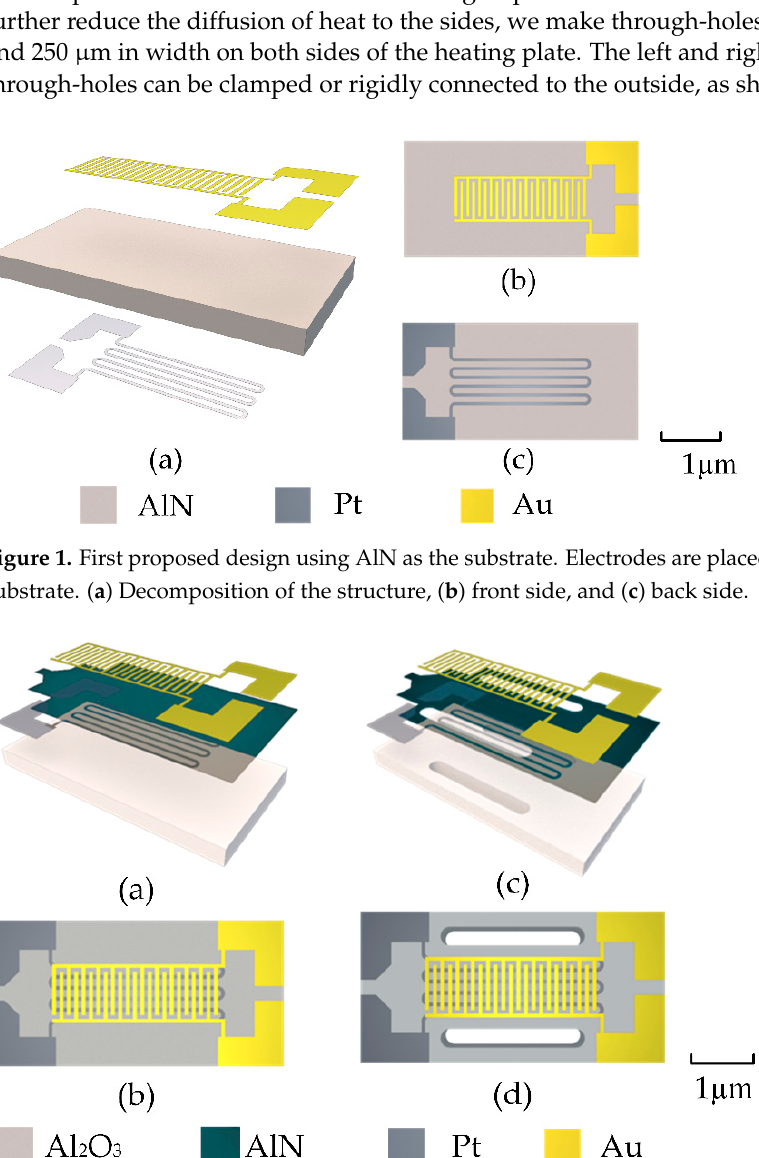
sign. To further reduce the diffusion of heat to the sides, we make through-holes 1650 μ m in length and 250 μ m in width on both sides of the heating plate. The left and right sides outside the through-holes can be clamped or rigidly connected to the outside, as shown in Figure 2c,d.